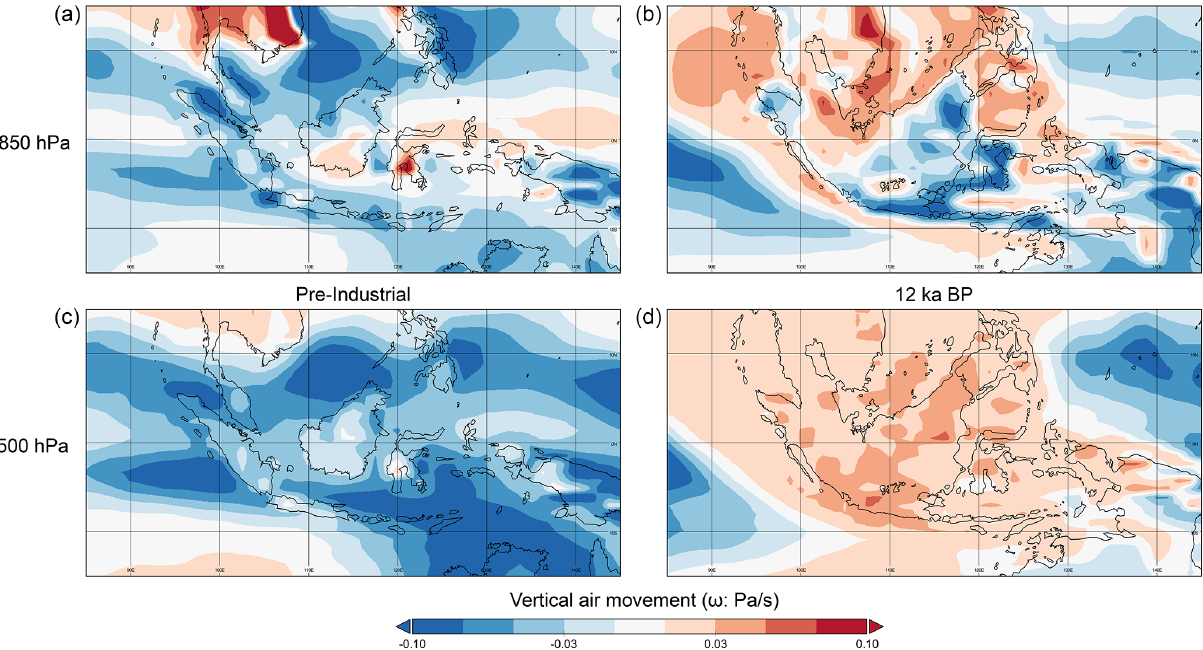
Figure 6. Comparison of near-surface convection and subsidence (850hPa level) with (no) deep convection ( ≥ 500hPa level) over ISEA during January for PI (a, c) and 12k (b, d) . As in Fig. 5, negative values (blue) indicate rising air/convection and positive values (red) indicate subsidence/breakdown of convection. Note that near-surface convection due to orography around Borneo at 12kaBP keeps all months humid ( > 60mm) while the overall deep convection of the PI is completely shut down over the whole IPWP region causing at least seasonal